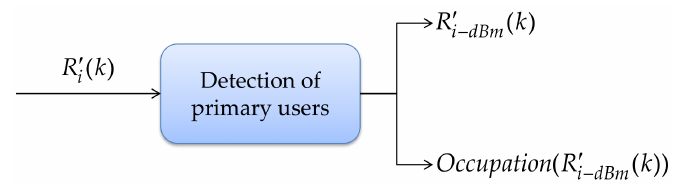
Figure 13. Detection of PU